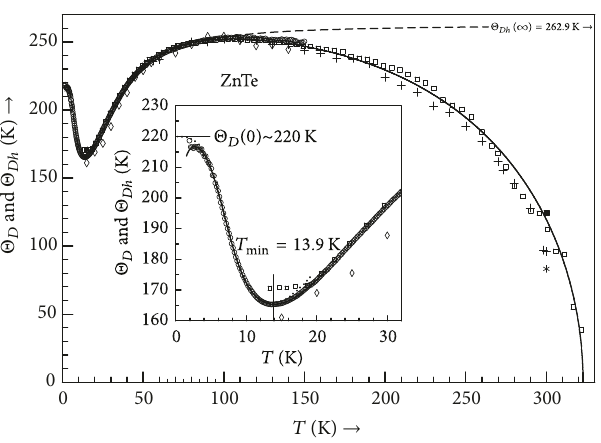
Figure 5: Effective Debye temperature values, Θ 𝐷 (𝑇) , as resulting for ZnTe from measured (isobaric) heat capacities, 𝐶 𝑝 (𝑇) ([46] ( I ), [38] ( ◻ ), [31] (+), [10] ( ◊ ), [80] ( ◼ ), and [81] ( ∗ )). The continuous curve for the true Debye temperature, Θ 𝐷ℎ (𝑇) (–– –––), is due to (28) in combination with (9) for the isochoric (harmonic) heat capacity shape function, 𝜅 ℎ (𝑇) ≡ 𝐶 𝑉ℎ (𝑇)/6𝑅 (according to the parameters listed in Table 1). The continuous curve for effective Debye temperature, Θ 𝐷 (𝑇) (solid curve), is due to (27) and (28) in combination with (5) and (9) for the associated isobaric (anharmonic) heat capacity shape function, 𝜅(𝑇) ≡ 𝐶 𝑝 (𝑇)/6𝑅 . The dotted curve (in the inset) shows the low-temperature dependence of the true Debye temperature, Θ 𝐷ℎ (𝑇) , according to